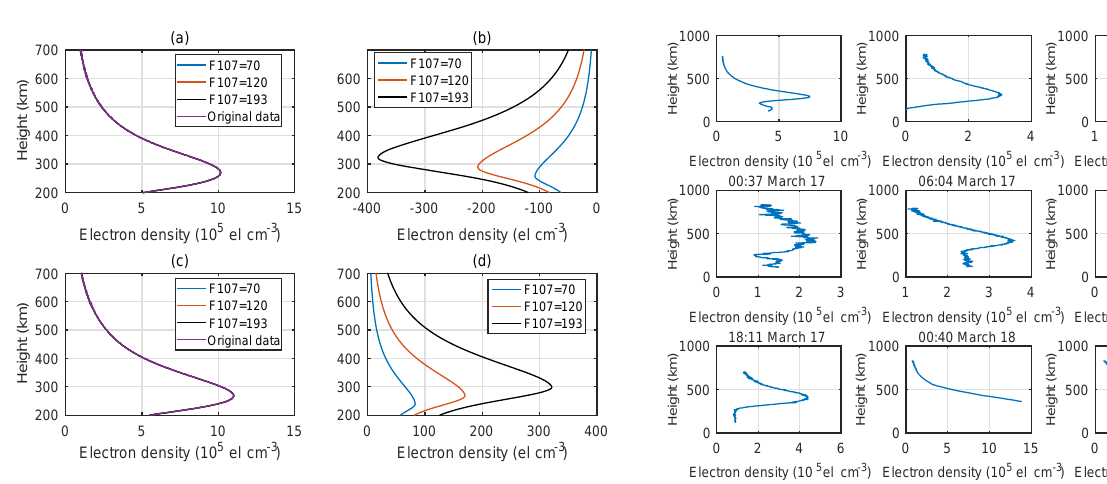
Figure 11. Panels (a) and (c) are profiles of the ionospheric elec- tron density; (b) and (d) are the high-order ionospheric effects with different F10.7cm indices.